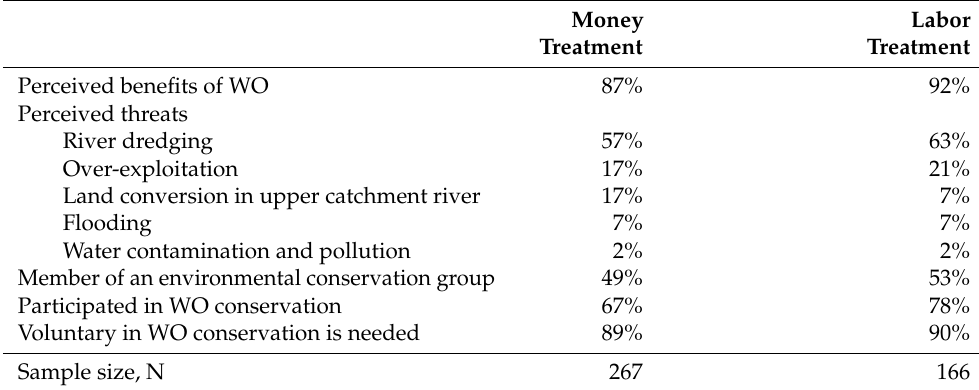
Table 5. Respondents’ perception, experiences, and participation regarding